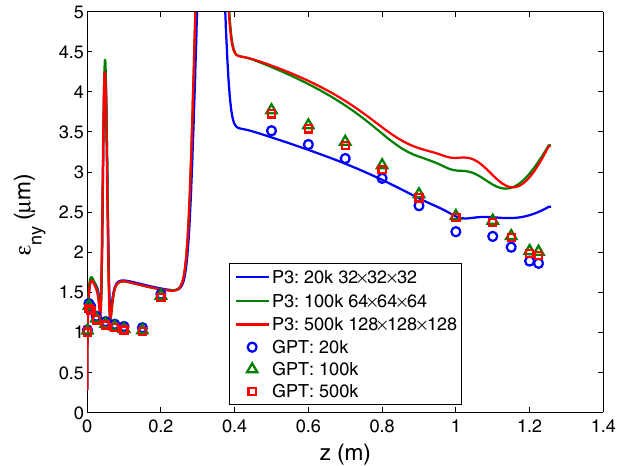
FIG. 9. (Color) Comparison of emittance vs longitudinal posi- tion calculations for PARMELA3D (solid lines) and GPT (open symbols) for 80 pC charge per bunch. The solenoid current is 3.6 A and the gun voltage is 250 kV.